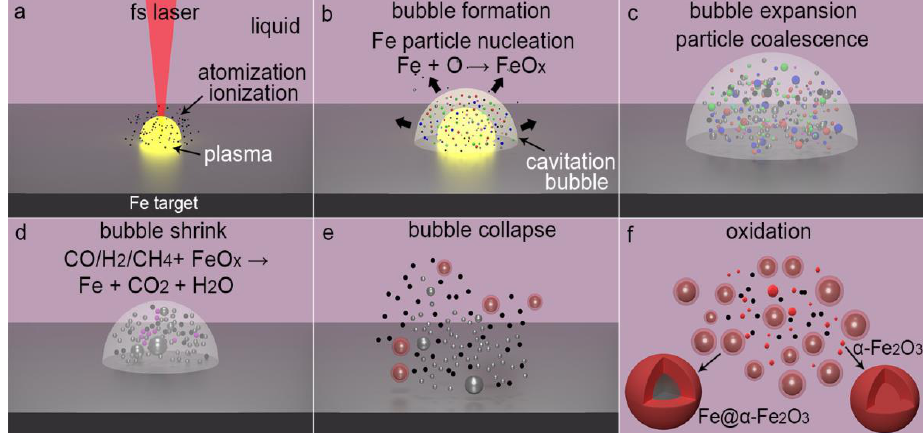
Figure 9. ( a – f ) Schematic of formation mechanism for Fe@α -Fe 2 O 3 particles by fs-LAL of Fe in acetone. Oxygen radicals that react with Fe atoms to from FeO x come from fs laser induced decomposition of acetone and dissolved oxygen. Fe: grey color, C: black color, α -Fe 2 O 3 : red color, other FeO x phases: green and blue color. Note that the shockwaves [59] generated during bubble collapse can push the already formed α -Fe 2 O 3 ultrasmall particles towards Fe@FeO x particles to be captured by the FeO x shells.